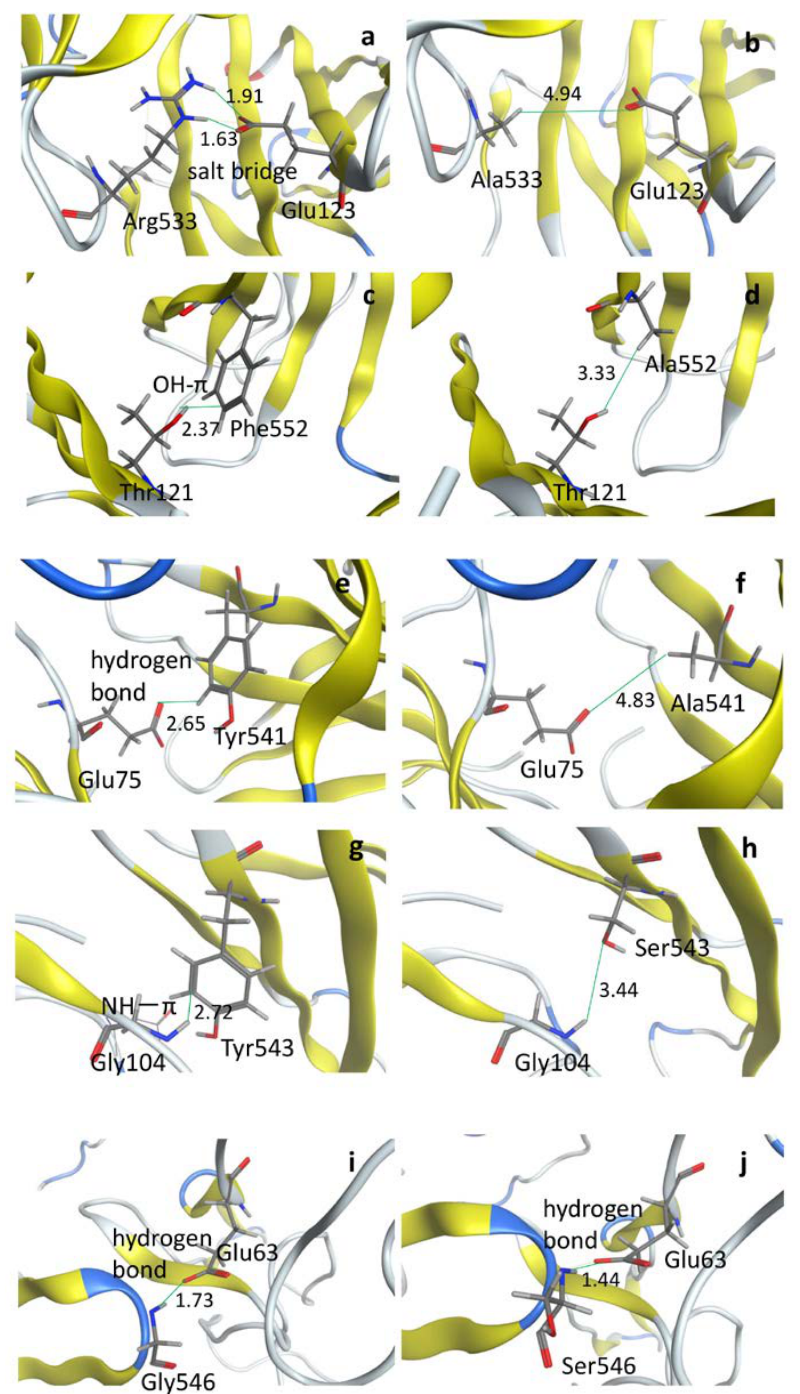
Figure 4. Local binding structures ( a ) before and ( b ) after the R533A mutation in the MVH–SLAM complex; ( c ) before and ( d ) after the F552A mutation in the MVH–SLAM complex; ( e ) before and ( f ) after the Y541A mutation in the MVH–SLAM complex; ( g ) before and ( h ) after the Y543S mutation in the MVH–Nectin-4 complex; and ( i ) before and ( j ) after the G546S mutation in the MVH–CD46 complex. The residues important for binding are depicted in the stick representation, where grey, red, blue, and white colors refer to carbon, oxygen, nitrogen, and hydrogen atoms, respectively. Numerals indicate the respective distances (in units of Å) between two atoms forming important chemical bonds depicted by green lines.